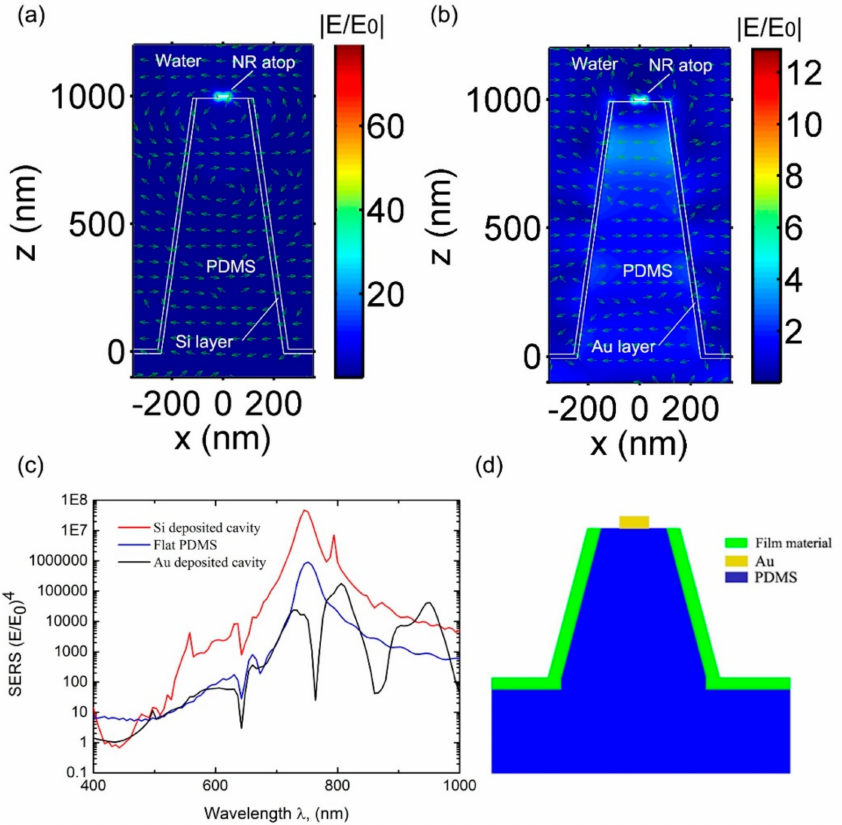
Figure 3. 758 nm electric field in cross sections of ( a ) Si coated ( b ) Au coated inverse cavity without nanorod ( c ) Electric filed enhancement spectrum comparison for 3 structures (Si-coated nanocone with one top nanorod, Au-coated nanocone, Nanorod on flat PDMS) ( d ) Illustration of the nanocone cross section with one